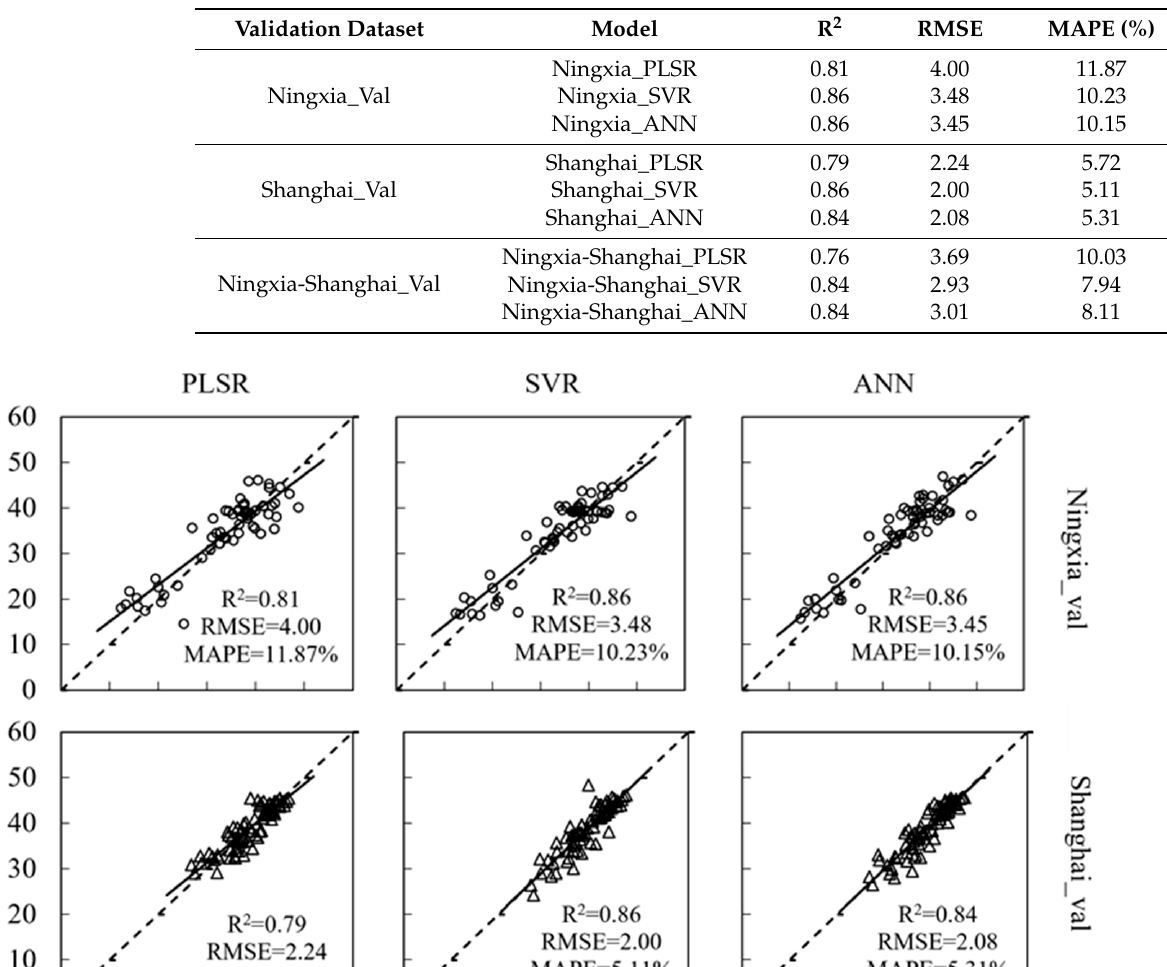
Table 6. Validation of rice leaf LCC estimation models for the same group.